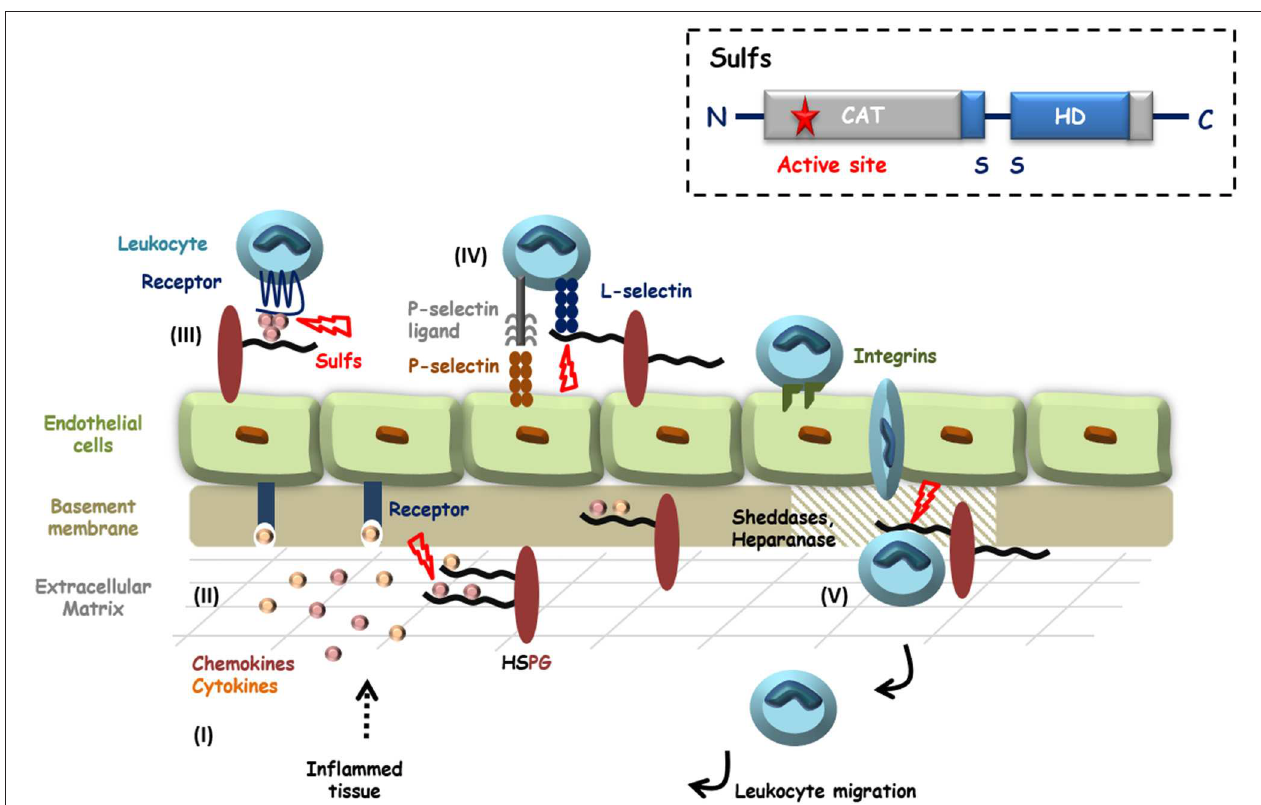
FIGURE 1 | HS in inflammation and potential roles of the Sulfs. Inflammatory stimuli induce the secretion of cytokines and chemokines (I) that activate endothelial cells and blood circulating leukocytes. HS controls the diffusion of these pro-inflammatory proteins, their oligomerization and the establishment of chemotactic gradients (II and III). Activated Leukocytes then adhere and roll over endothelial cells, through interactions of E- and P-selectins with their counter ligands. L-selectin tightens cell-contacts by binding to sLe X decorated glycoproteins and HSPGs (IV). After passage through the endothelial layer, efficient migration of leukocytes toward inflammatory sites requires the degradation of basement membrane HSPGs by proteases and Heparanase (V). HS is thus largely involved during inflammation and HS 6- O -sulfation is critical for most of these interactions. Although still poorly investigated, Sulfs could therefore play different roles during inflammation. In the figure, steps during which Sulfs could be implicated are highlighted with red bolts. Inset: schematic representation of Sulf structural